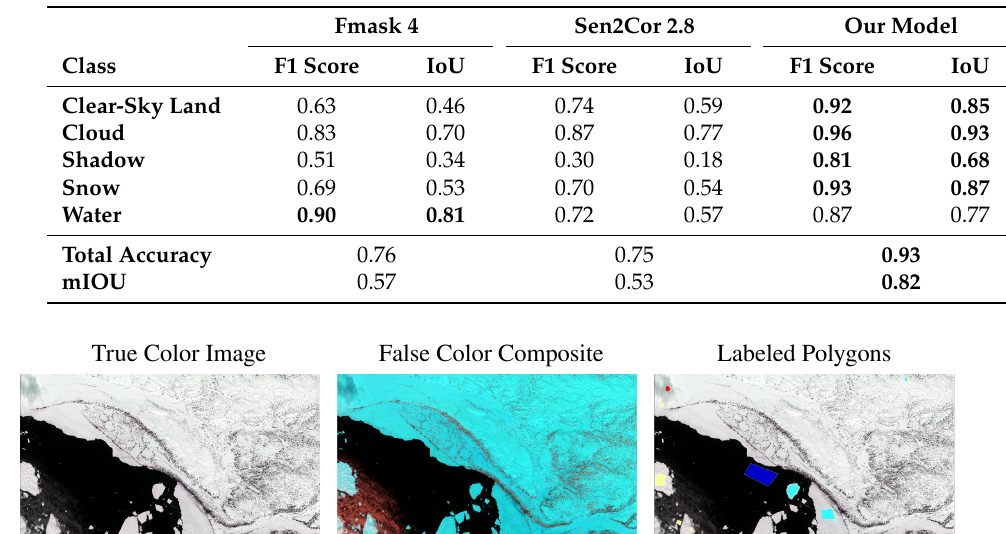
Table 9. Comparison of F1 score and IoU with Fmask 4 and Sen2Cor 2.8.